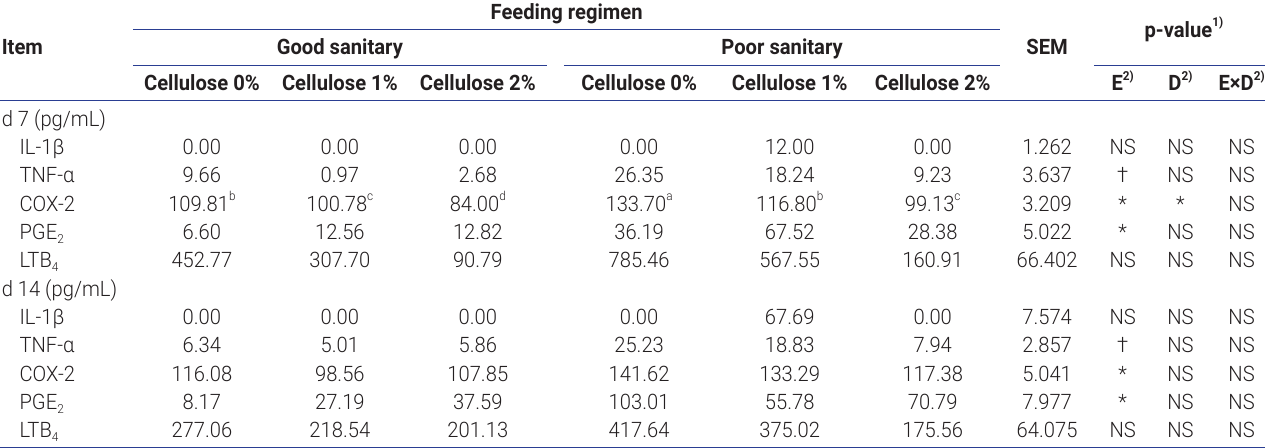
Table 8. Effects of environmental conditions and cellulose levels on pro-inflammatory cytokines and lipid mediators for weaned pig for 14 days after weaning